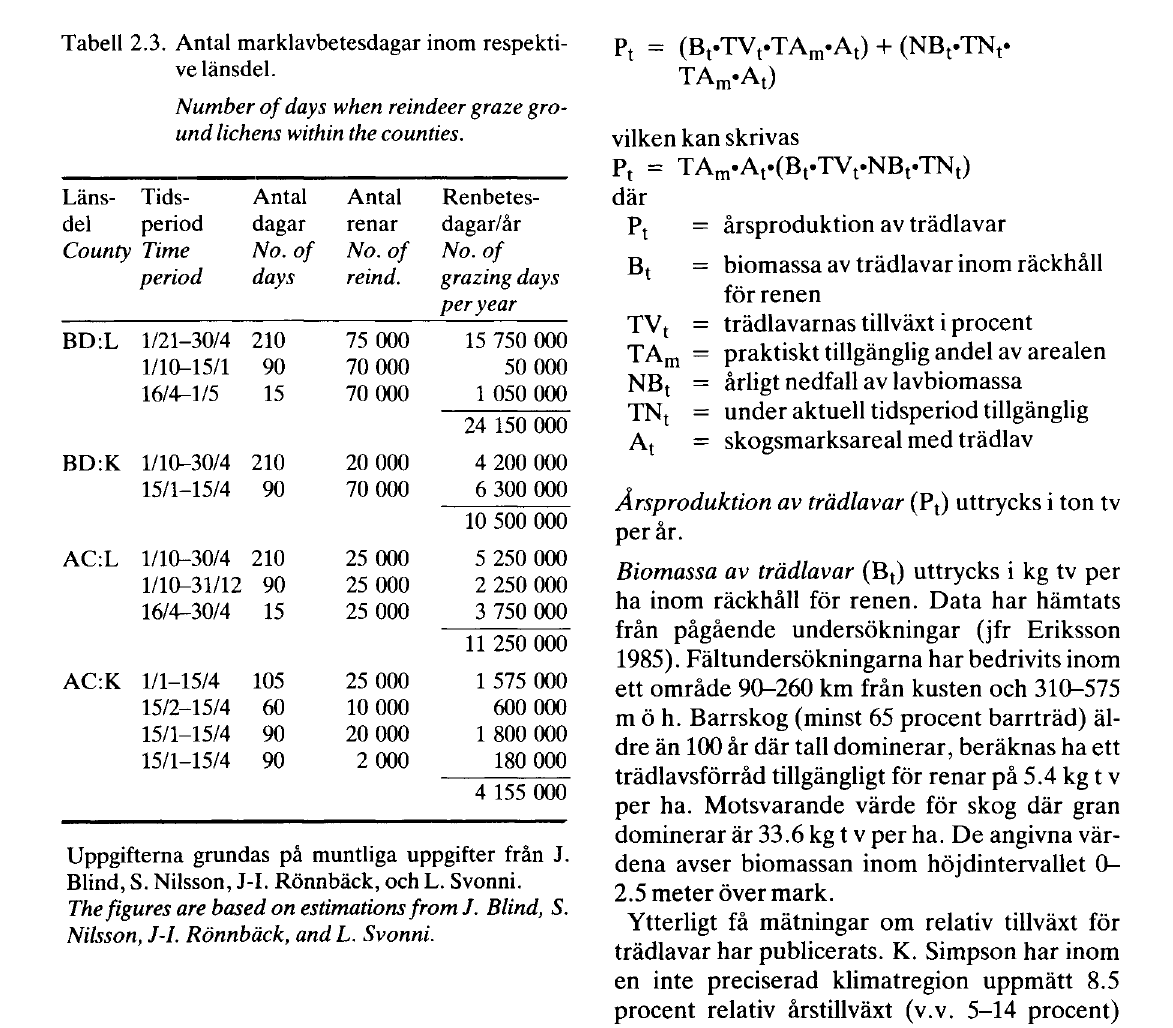
Tabell 2.3. Antal marklavbetesdagar inom respekti¬ ve